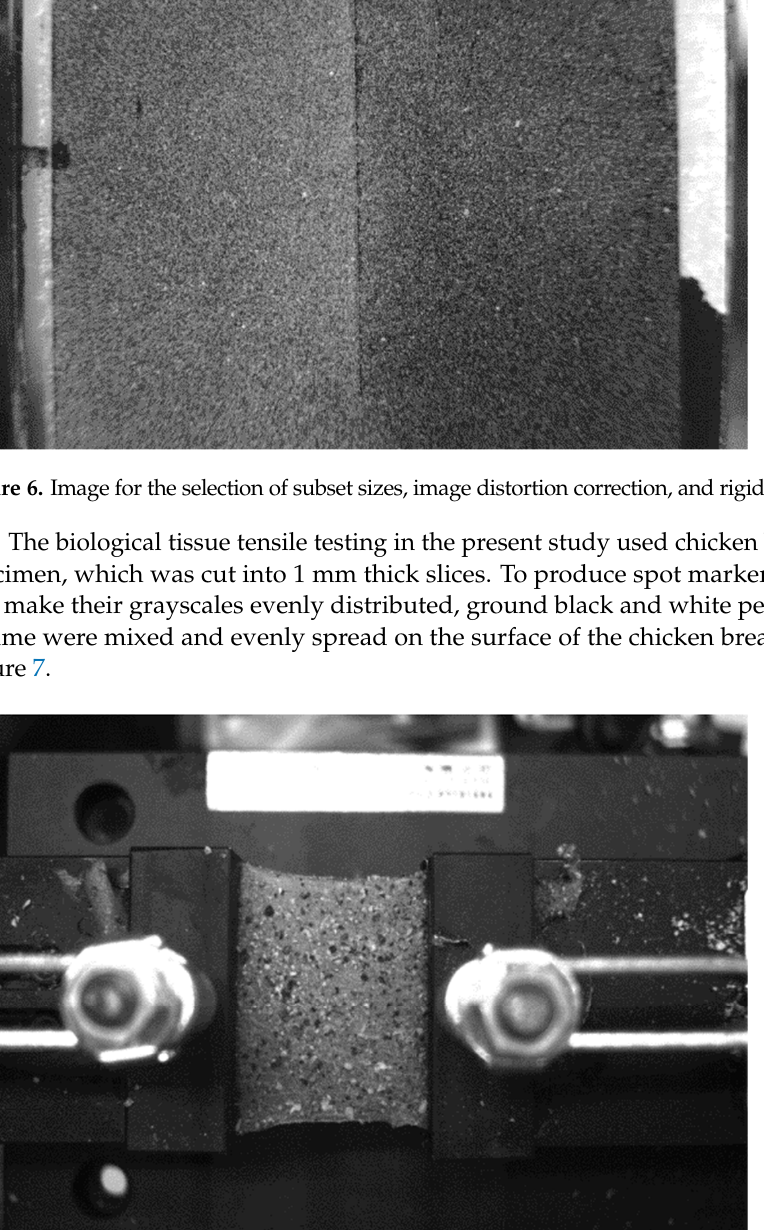
8 of 17 Figure 5. Experimental setup for biological tissue tensile testing.